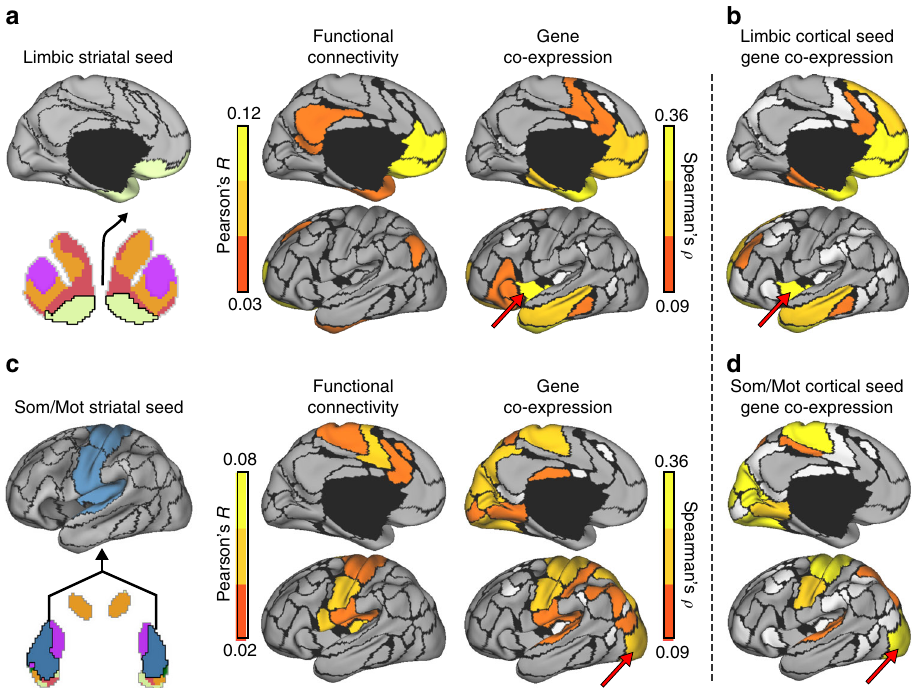
Fig. 4 Functional and genetic cortical correlations of limbic and somato/motor striatal seeds. a The correspondence of fcMRI correlation patterns between the limbic region of striatum with cortex was calculated for the 73 bi-hemispheric cortical parcels using Pearson ’ s r . Corresponding gene expression correlations were calculated using Spearman ’ s ρ . Only left-hemisphere maps are displayed (see Supplementary Fig. 4 for unthresholded, bi-hemispheric maps). White denotes regions without samples from at least two donors. Limbic functional and genetic maps were correlated, r = 0.32, p ≤ 0.01. b The cortical gene expression correlations of bilateral limbic OFC (as in Fig. 1d) were associated with the genetic correlation pro fi le of limbic striatum, r = 0.88, p ≤ 0.001. Red arrows highlight an example region where cortico-striatal genetic correlations differ from functional connectivity, but aligns to cortico- cortical genetic correlations of the limbic OFC. c The functional and genetic correlations of the somato/motor striatal seed region. d The cortical gene expression correlations of bilateral dorsal somato/motor cortex (from Fig. 1e) followed the genetic correlation pro fi le of somato/motor striatum, r = 0.92, p ≤ 0.001. Red arrows highlight an example region where cortico-striatal genetic correlations differ from functional connectivity, but aligns to cortico- cortical genetic correlations of the dorsal somato/motor